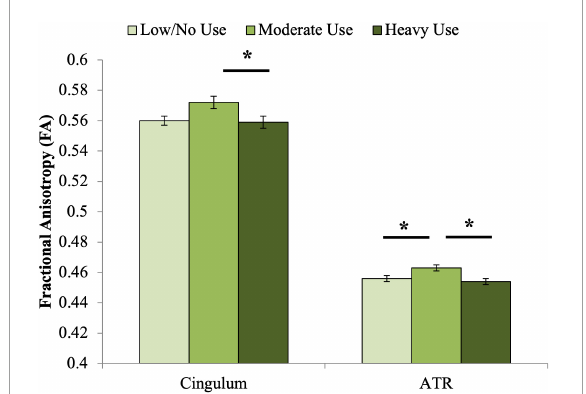
FIGURE1 Associations between adolescent cannabis exposure and FA of the cingulum and ATR at age 20. Significant associations were observed between adolescent cannabis exposure group and FA of both the cingulum and anterior thalamic radiations. For the cingulum, Bonferroni-corrected pairwise post hoc tests demonstrated that FA of the moderate adolescent use group was significantly higher than the heavy adolescent use group ( p corrected < 0.05). For the anterior thalamic radiations, Bonferroni-corrected pairwise post hoc tests demonstrated that the moderate use and low or no use groups differed significantly ( p corrected < 0.05), as did the moderate and heavy use groups ( p corrected < 0.01). *indicates significant Bonferroni-corrected post hoc pairwise